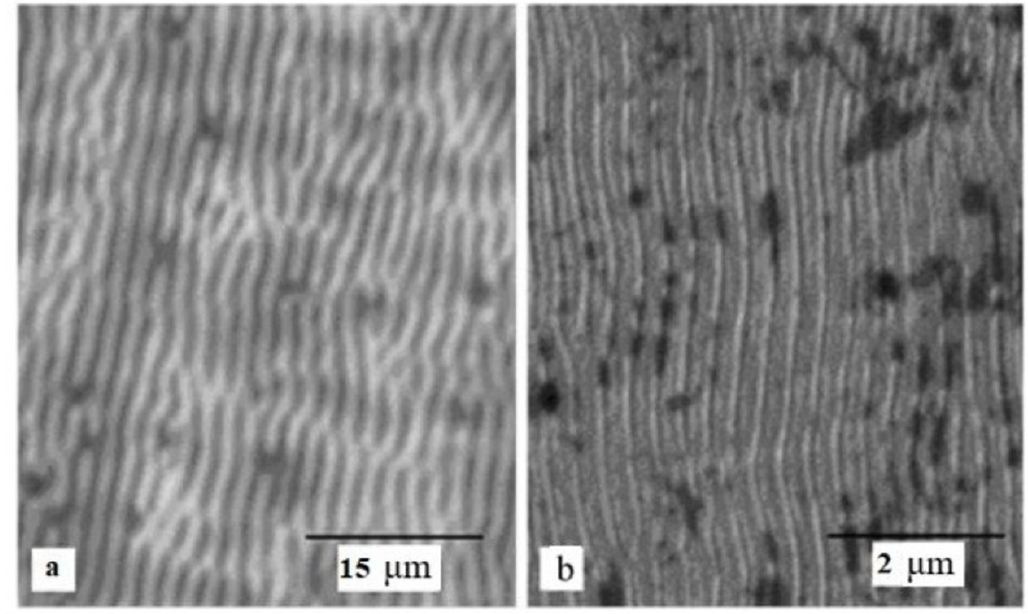
Figure 3: Images of wavy structures on the surface of the ta-C films formed after laser treatment using the main wavelength (a) and a double frequency (b) (overlap of pulses 57%; H = 3.61 J/cm 2 (a); H = 14.25 J/cm 2 (b))